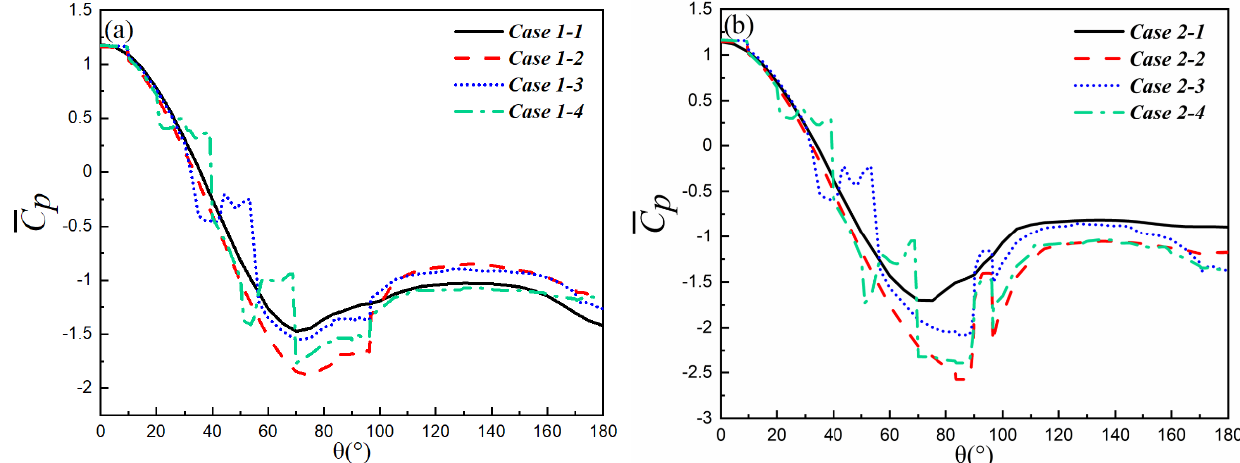
Figure 5. Distribution of time-averaged pressure coefficient over the cylinder surface with different dimpled numbers: ( a ) Re = 1 × 10 5 ; ( b ) Re = 2 × 10 5 .